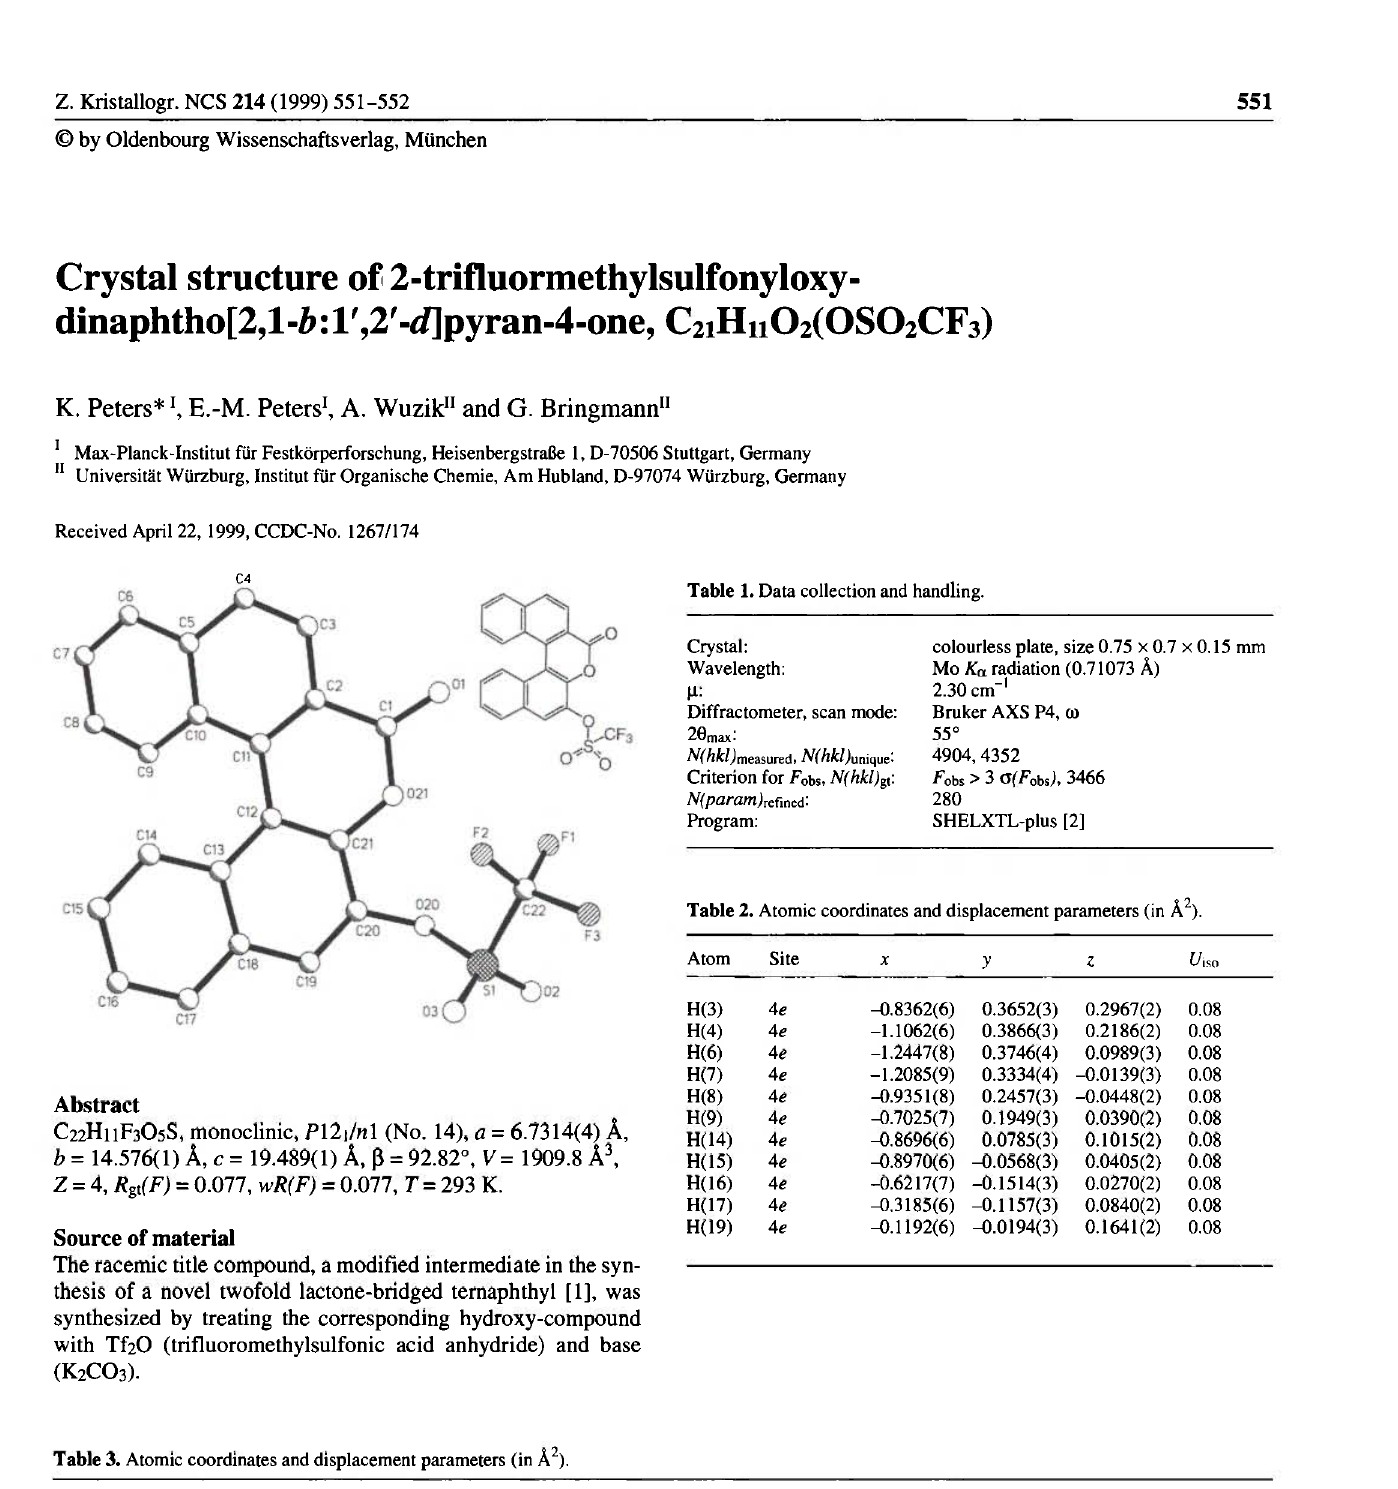
Table 3. Atomic coordinates and displacement parameters (in Ä 2